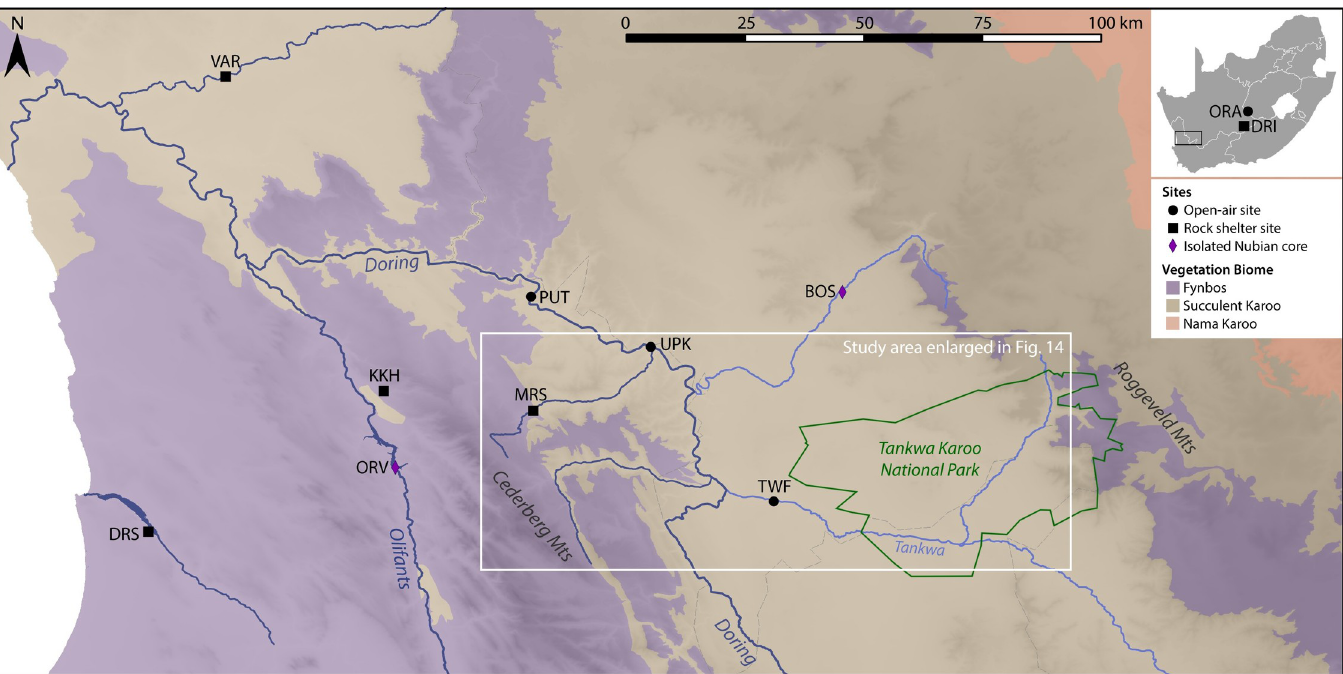
Fig 1. Map of the Tankwa Karoo and relevant sites in South Africa. Site abbreviations (west to east): DRS Diepkloof, VAR Varsche Rivier, KKH Klein Kliphuis, ORV Olifants River Valley, PUT Putslaagte 1, MRS Mertenhof, UPK Uitspankraal 7, TWF Tweefontein, BOS Bos River, DRI Driekoppen, ORA Orangia 1. Open-source spatial data from NaturalEarthData.com, NASA SRTM Version 3.0, and South African National Biodiversity Institute (bgis.sanbi.org). Vegetation data from the National Vegetation Map Project 2012 (VEGMAP), after [18].